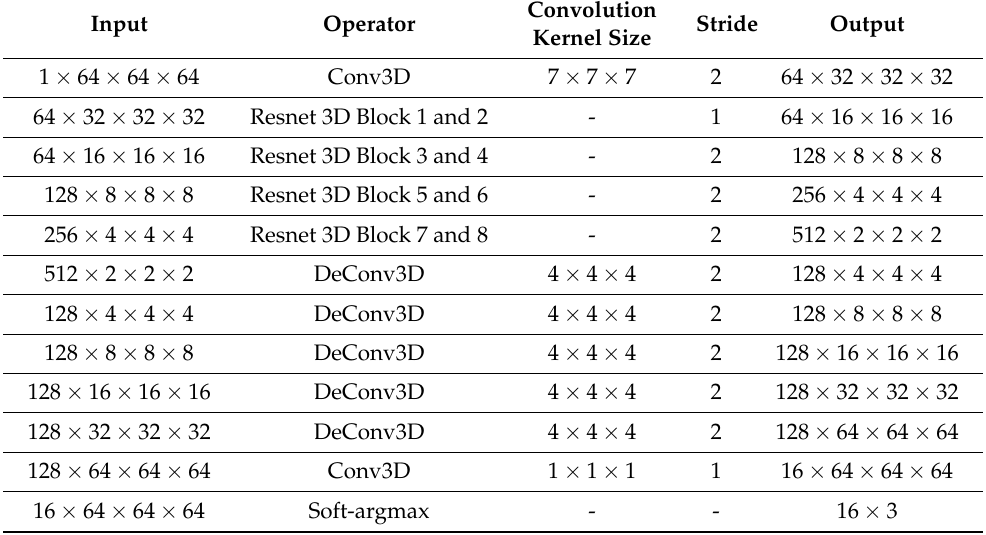
Table 1. Overall 3D CNN network structure